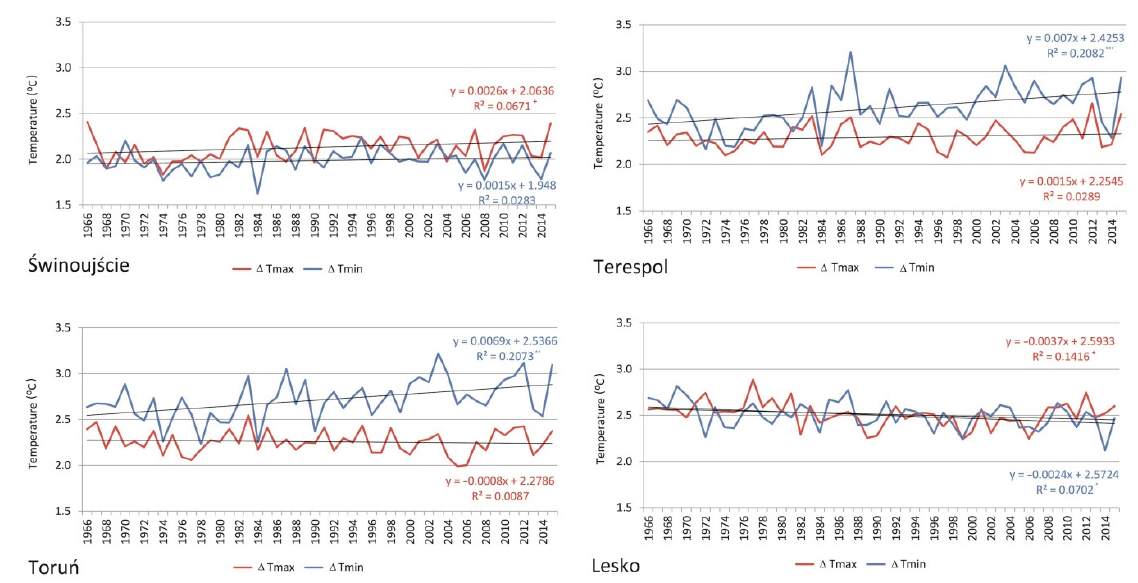
Figure 4. Annual mean day-by-day ∆ Tmax and ∆ Tmin course in selected stations in Poland in the years 1966–2015 with the